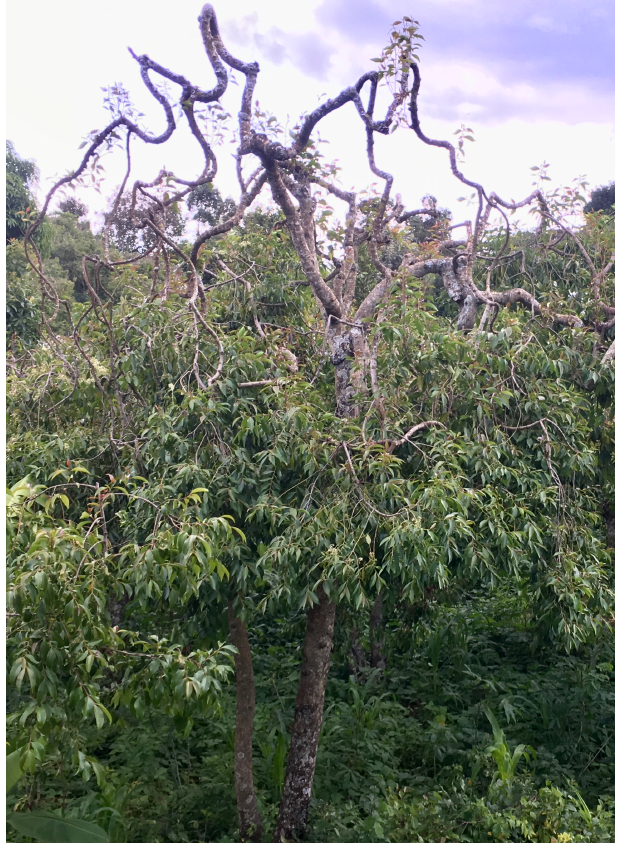
Fig. 1 . Khat ( Catha edulis ) tree with